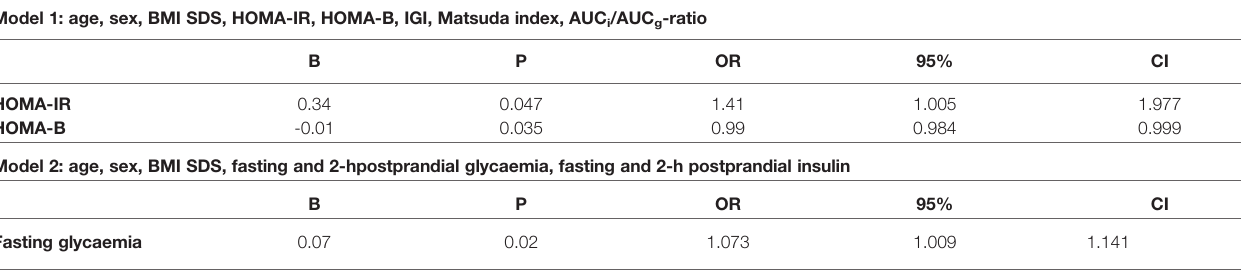
TABLE 4 | Stepwise multiple logistic regression analysis of variables affecting serum asprosin